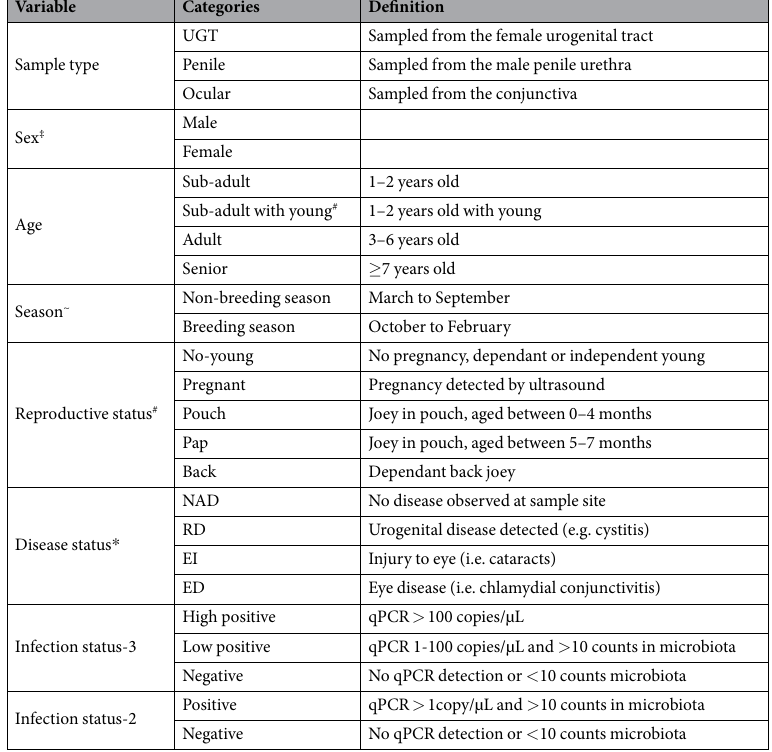
Table 1. Definition of variables associated with koalas used in this study. ‡ Used for analysis of ocular samples only. # Female UGT samples only. * Disease status at the sample site. ~ Based on male reproductive season in South East Queensland 56 which defines female reproductive cycles 57